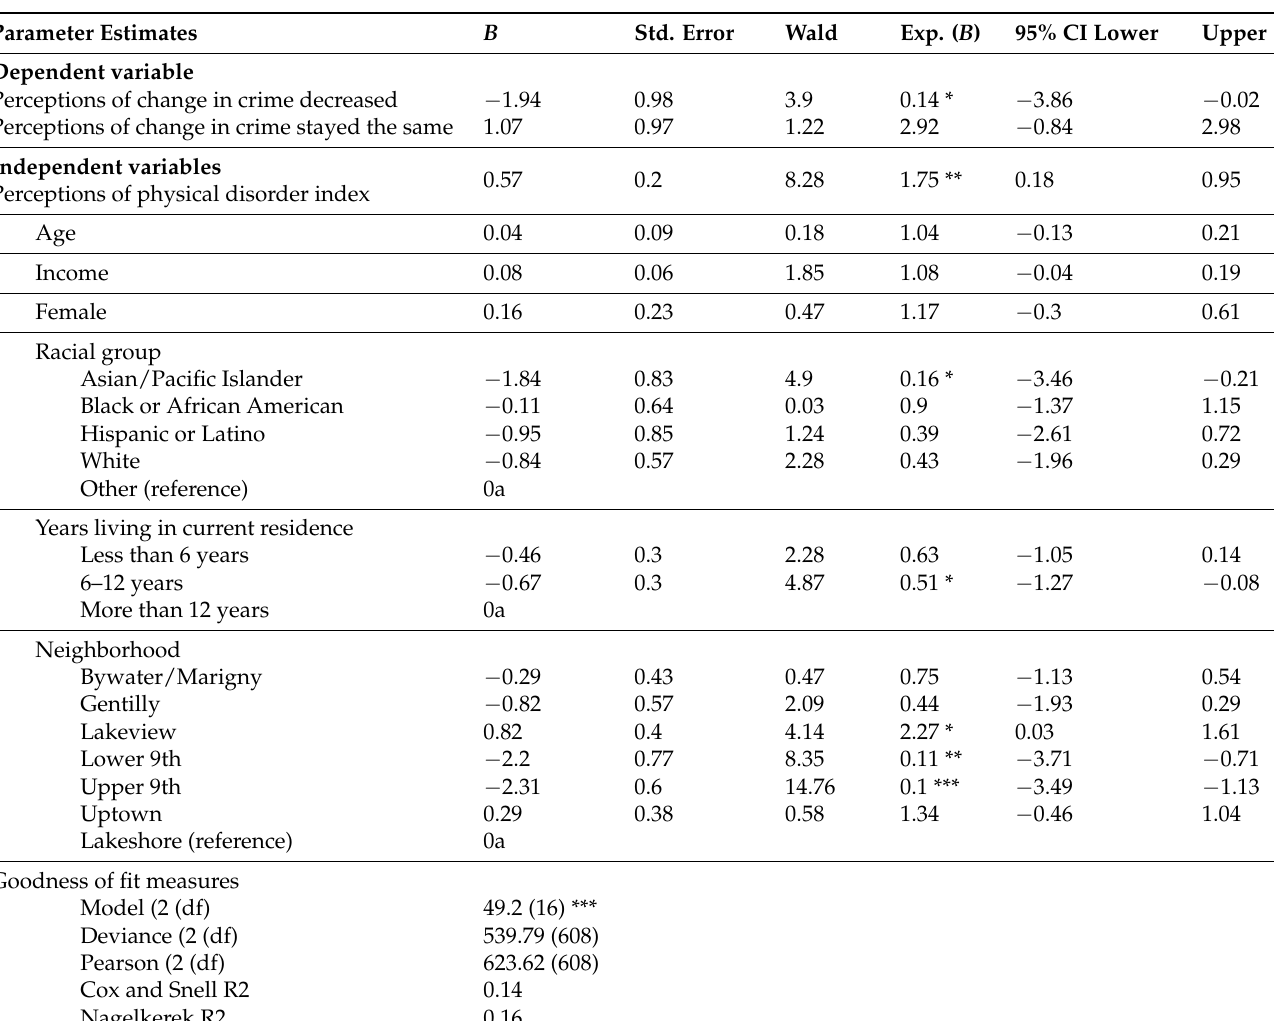
Table 4. Parameter Estimates of Ordinal Logistic Regression Model Predicting Perceptions of Neigh- borhood Disorder, Socio-Demographic Characteristics, and Neighborhood on Perceptions of Change in